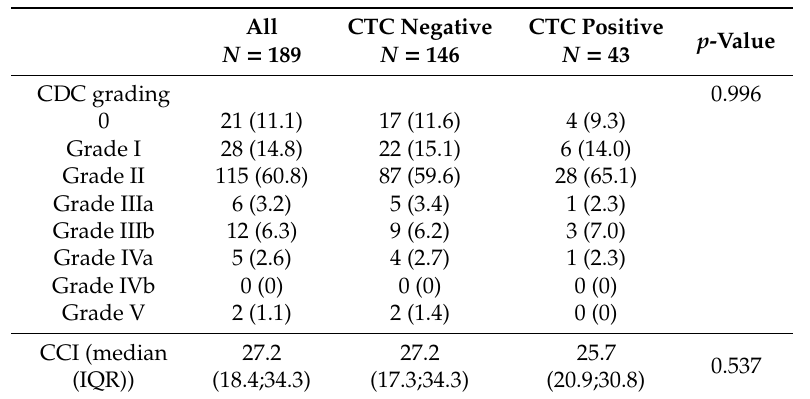
Table 4. CDC grading and CCI ® score of 30-day postoperative complications in 189 UCB patients who underwent radical cystectomy between 2007 and